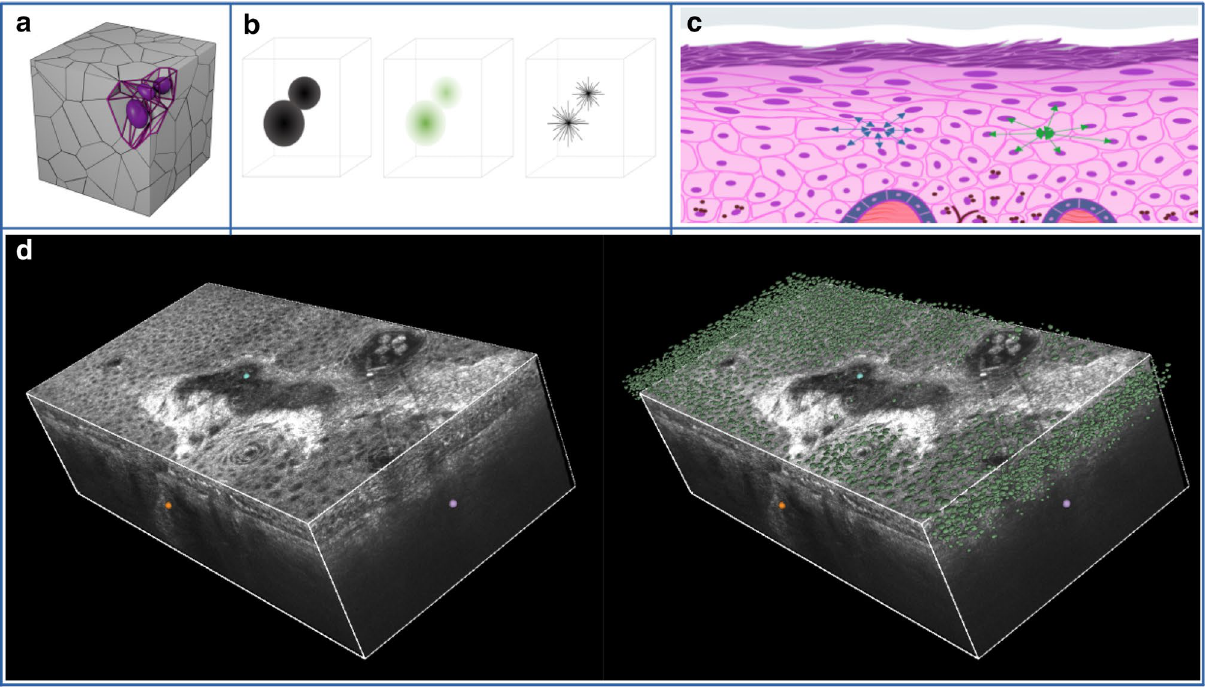
Figure 1. ( a ) Representation of a 3D Voronoi Diagram in a cube. ( b ) Scheme of a StarDist inputs, probability predictions and rays predictions. ( c ) Representation of skin structure, center to center distance (in green) and border to border distance (in blue). ( d ) Example of 3D visualisation of StarDist nuclei detection in LC-OCT 3D